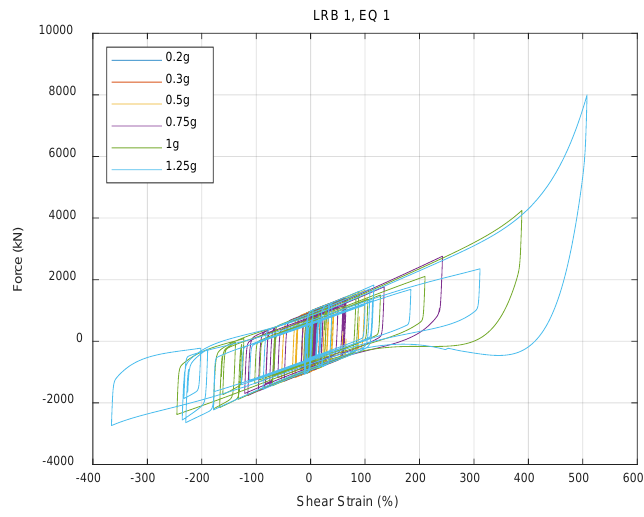
Figure 10. Hysteresis of LRB #1.3.2. Floor Response Spectra of an Isolated NPP.